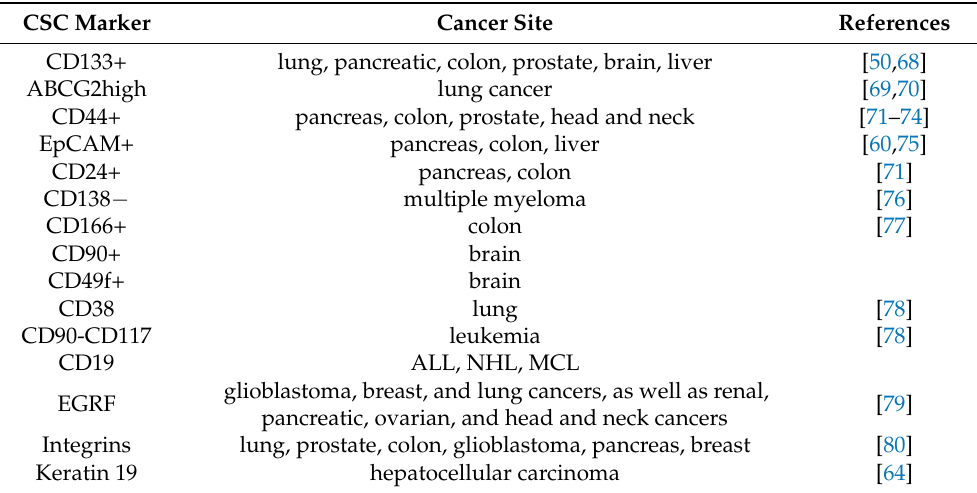
Table 2. Selected examples of CSC markers that can be utilised in